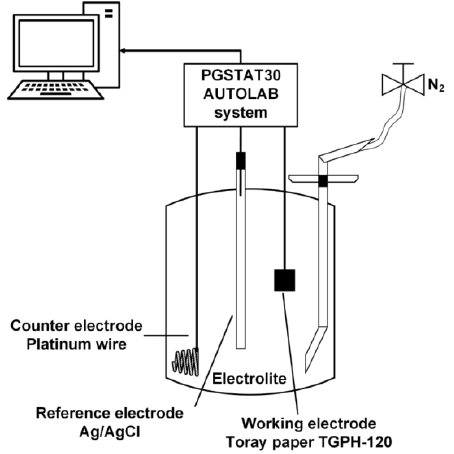
Figure 1. Scheme of a three-electrode electrochemical cell.